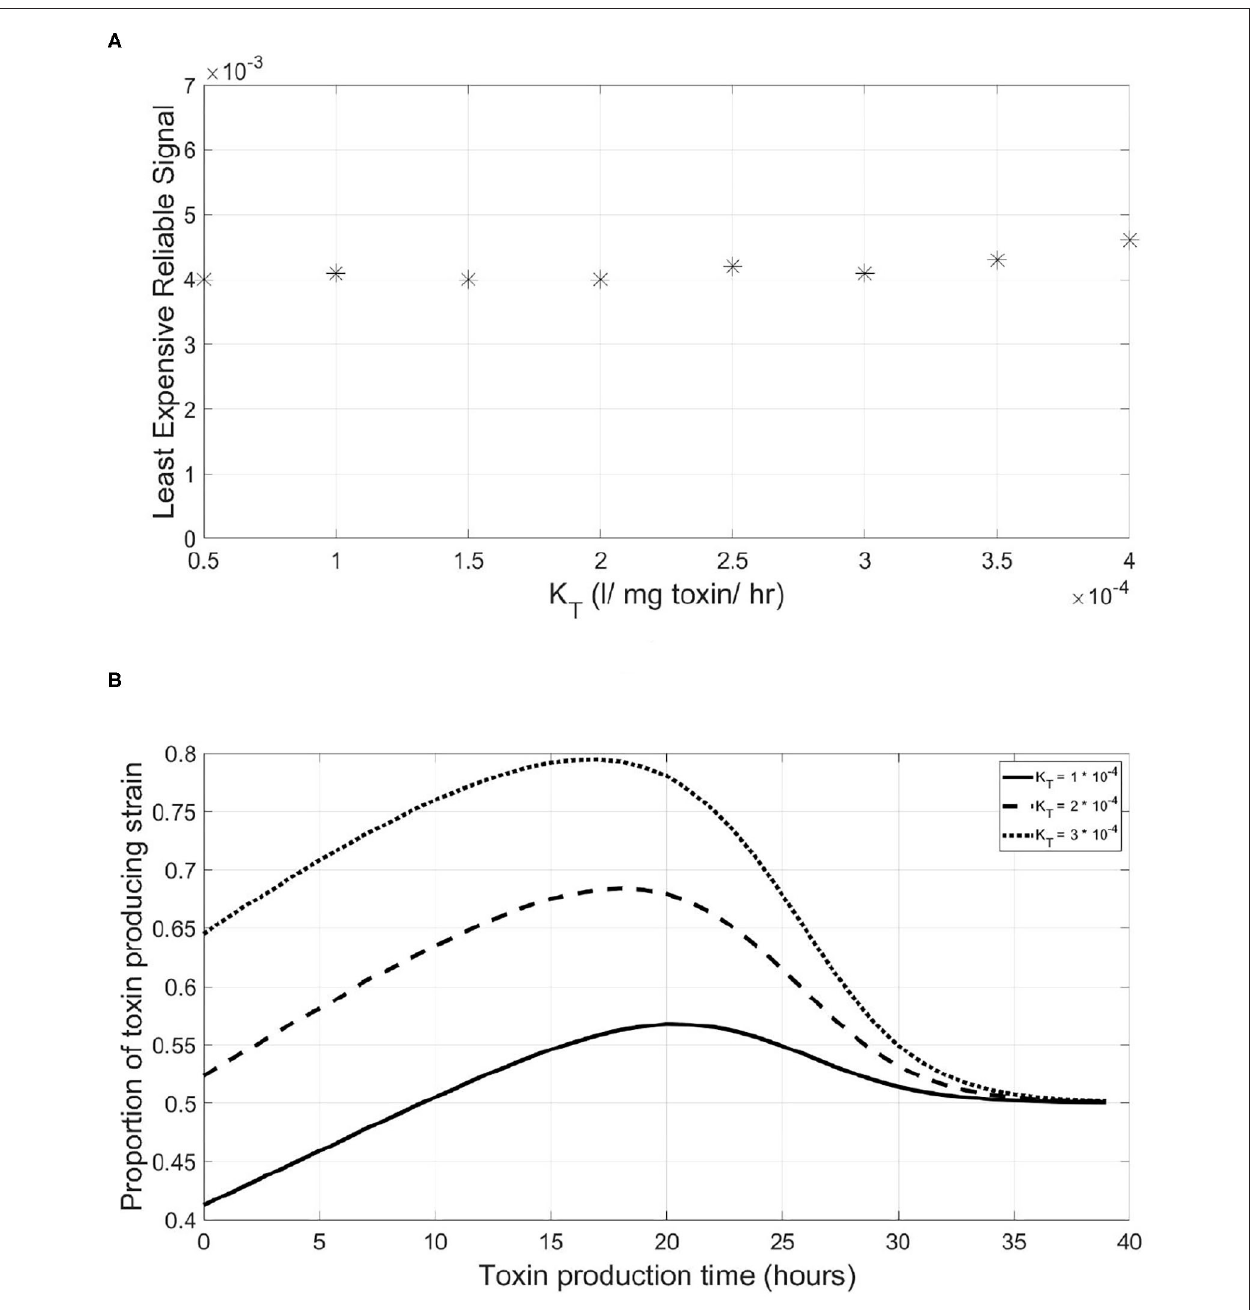
FIGURE 6 | The Least Expensive Reliable Signal to protect the QS regulation system of a QS toxin producing strain is insensitive to increasing toxin lethality. This is due to the little variation observed in the slope of the fitness-toxin production time curve under increasing levels of toxin lethality. (A) The relationship between the least expensive reliable signal and the lethality of the toxin produced by a QS toxin producing strain. (B) The final fitness of a QS toxin producing strain, expressed as its proportion in the population at the end of a simulation, vs. the time at which toxin production starts by the said strain under different values of toxin